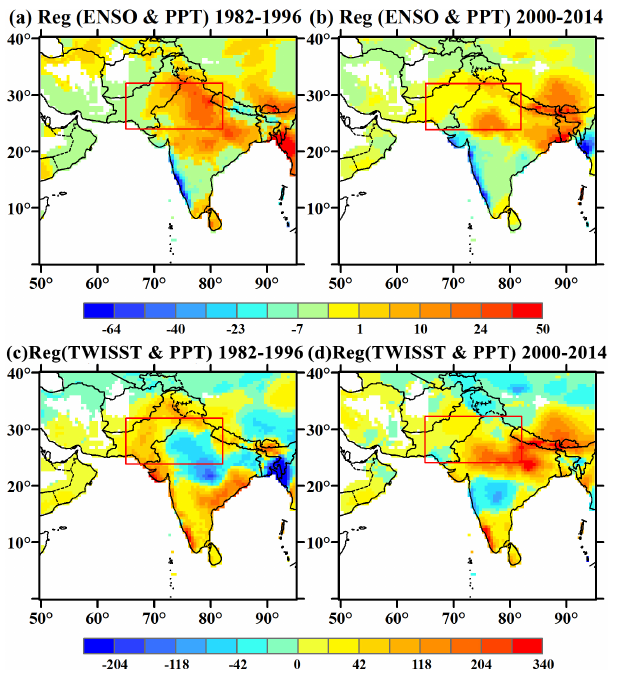
Figure 13. (a–b) Regression of ENSO with TWISST-related sig- nals removed onto SoilM in the dust season (June–July). (c–d) Re- gression of TWISST with ENSO-related signals removed onto SoilM in the dust season